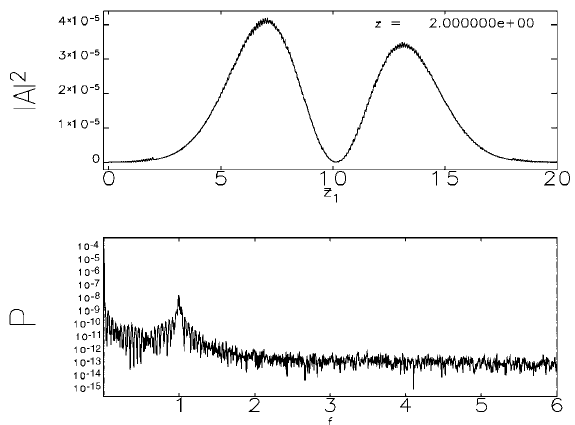
FIG. 7. Top panel: The scaled intensity, j A j 2 , as a function of for a scaled distance through the scaled pulse position (cid:9) zz 1 interaction region of (cid:9) zz (cid:1) 2 and a Gaussian profile electron (cid:1) 18 and (cid:18) (cid:1) 3 . Bottom panel: pulse of total duration (cid:9) ll e e The scaled PSD, P , of the radiation as a function of the scaled frequency f